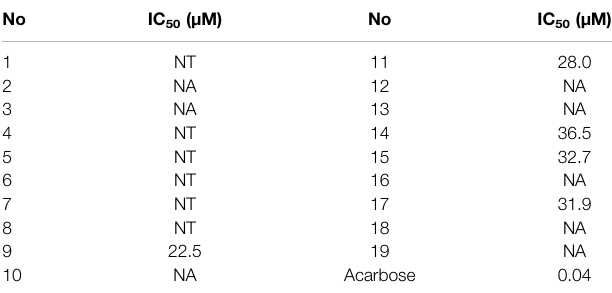
TABLE 3 | α -Glucosidase inhibitory activities of compounds 1 – 19